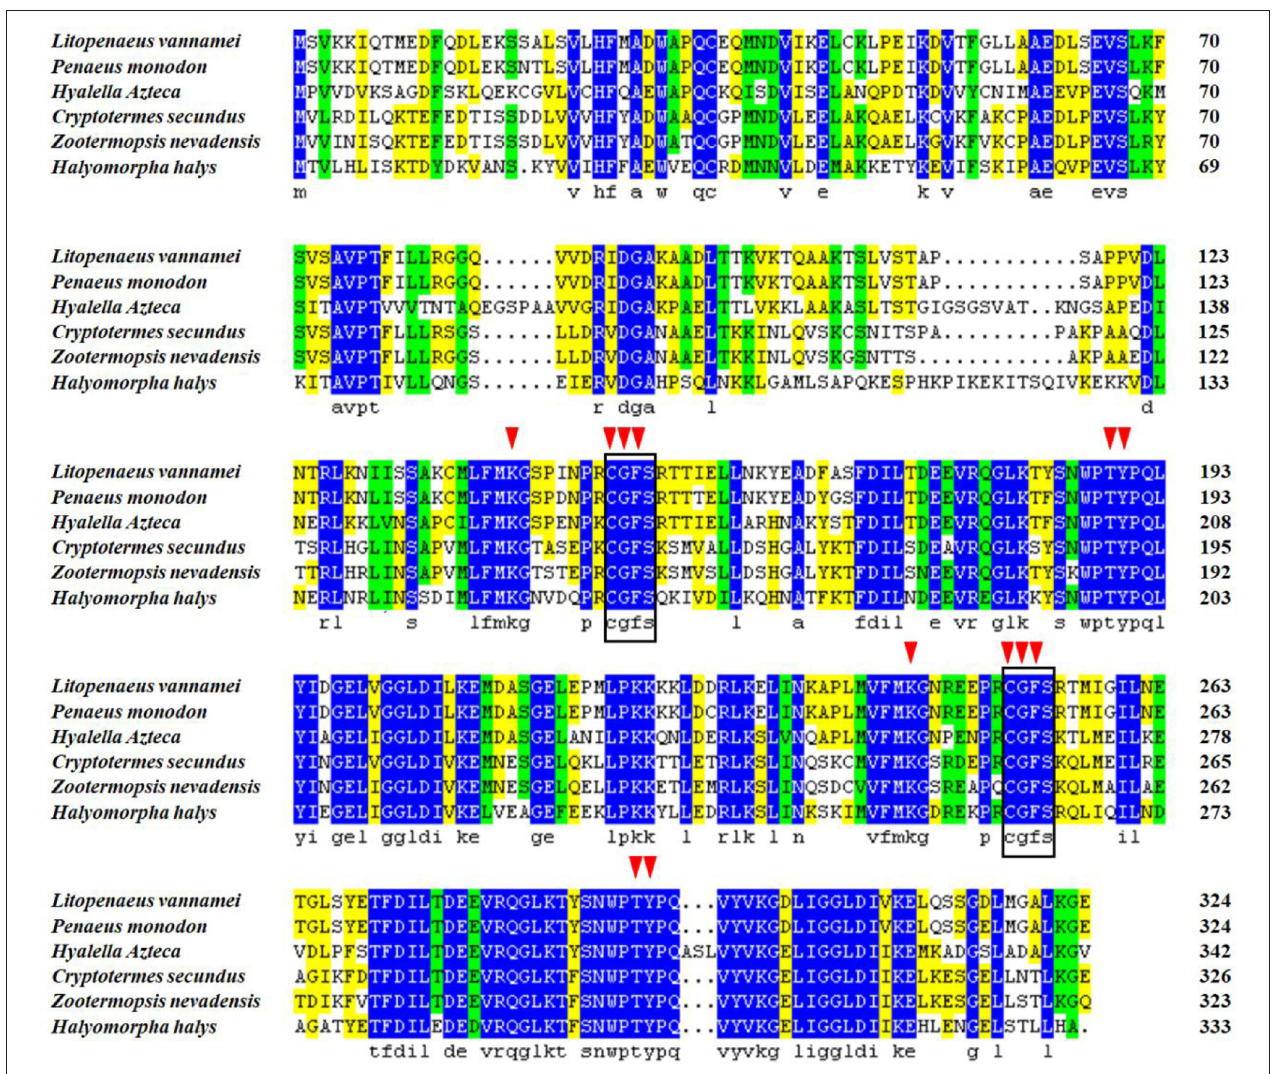
FIGURE 2 | Multiple sequence alignment of Grx 3 in Pacific white shrimp ( Litopenaeus vannamei ). The blue region indicates that the sequences share the same amino acid residue. Gaps are indicated by spots. A square line box shows the special catalytic residues, and red triangle arrows represent 12 GSH binding